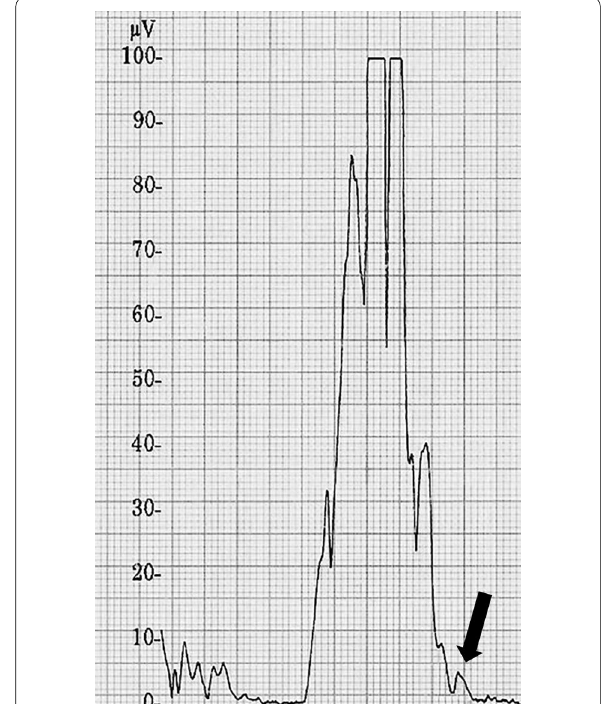
Fig. 1 Ventricular late potential detected by signal averaged electrocardiography. Arrow indicates ventricular late potential. This subject showed filtered QRS duration 127 ms, duration of low = amplitude late potential < 40 uV 51 ms, and root‑mean‑square = voltage in terminal 40 ms 17 =